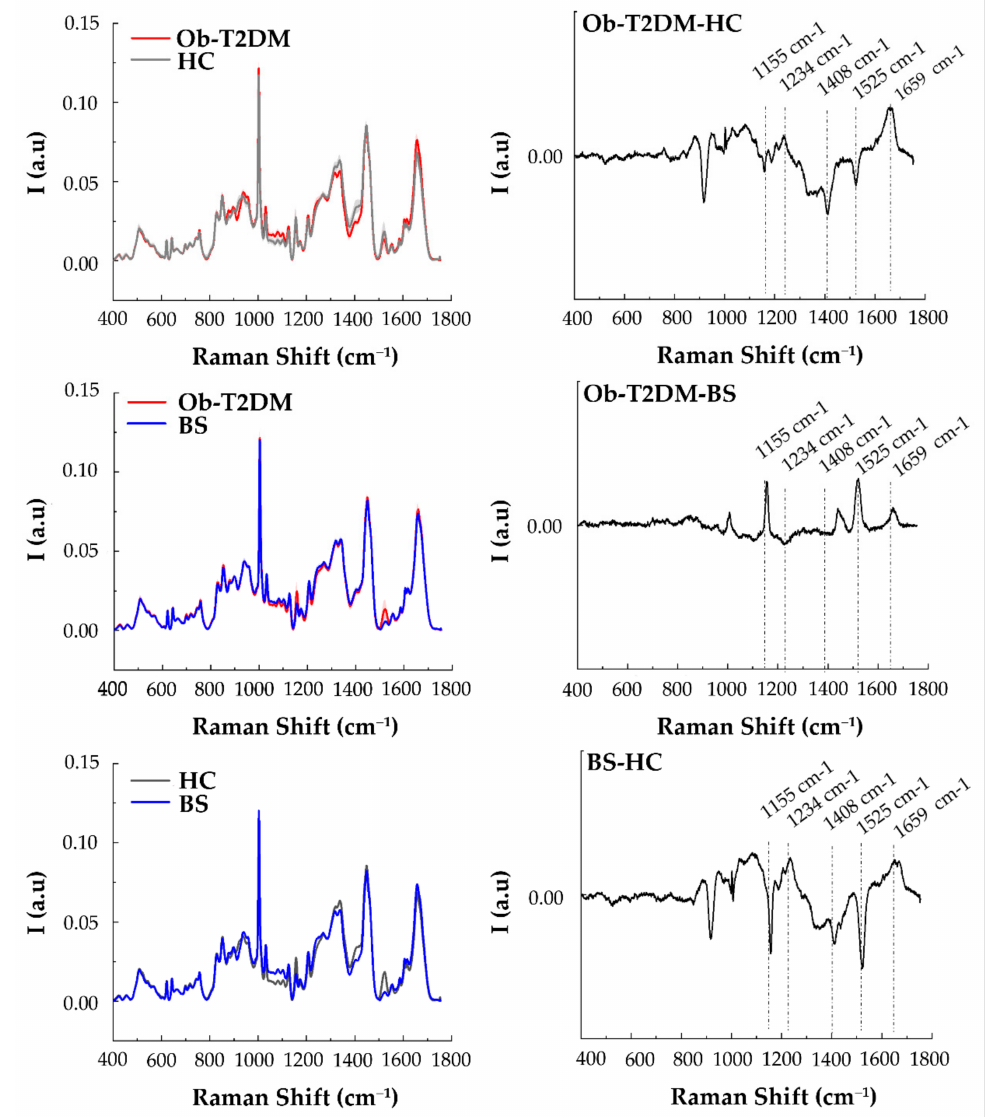
Figure 4. The differential spectrum of all groups; obese type 2 diabetes patients [Ob-T2DM; n = 14], bariatric surgery [BS; n = 14], and health control [HC; n = 23]. Dotted lines represent the peaks associated with different intensities between the